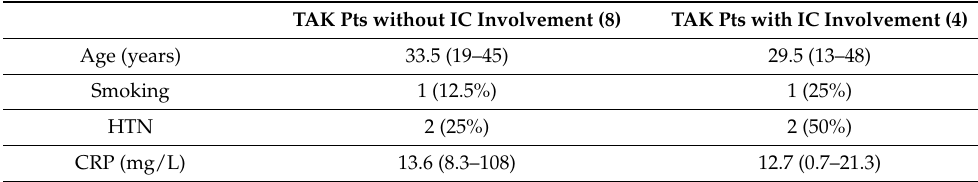
Table 3. Comparison of TAK patients with and without intracranial artery